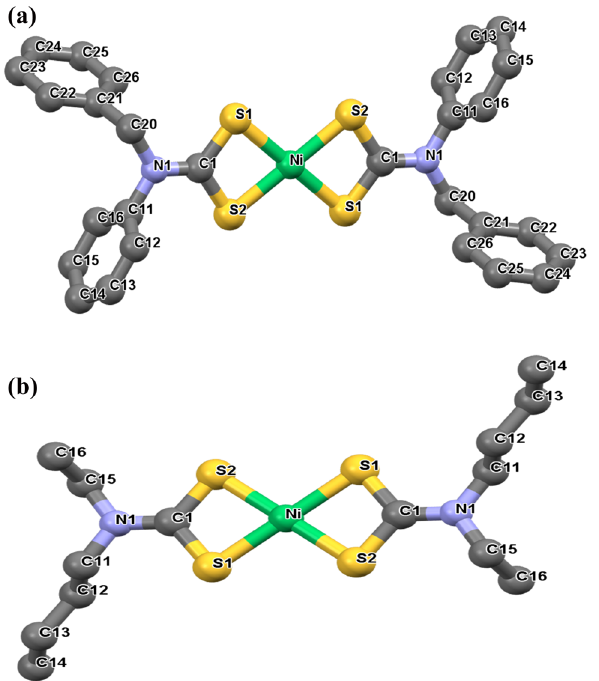
Figure 10: Molecular structure of ( a ) Ni ( S 2 CN ( phenyl )( benzyl )) 2 and ( b ) Ni ( S ( ethyl )( n - butyl )) [ 47 ] , with permission 2 CN 2 . Redrawn from ref. from Elsevier ( Copyright 2020 ) .